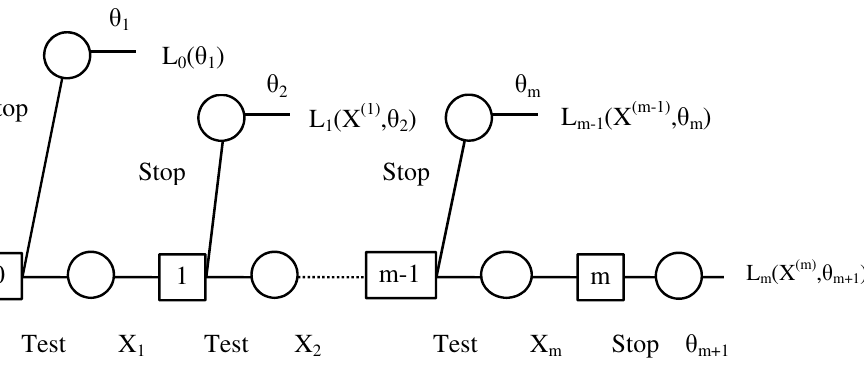
Figure 6. Decision tree for an optimal stopping